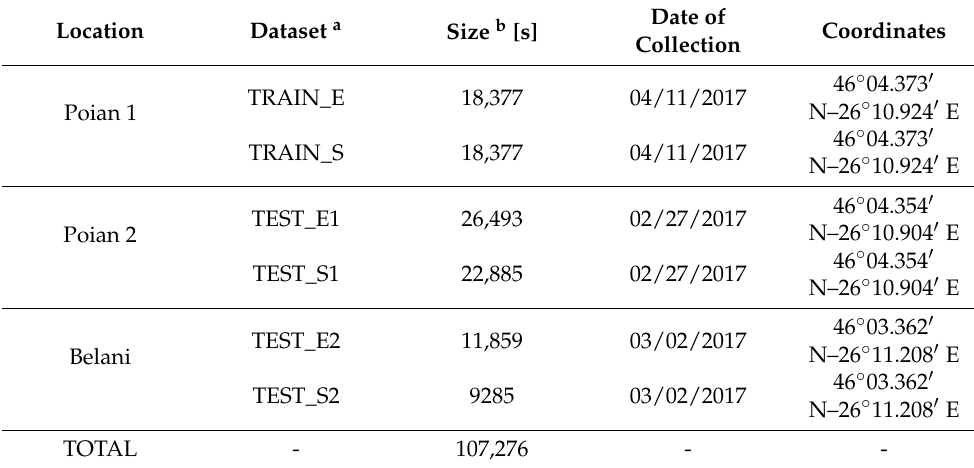
Table 1. Locations of data collection and the summarized description of the